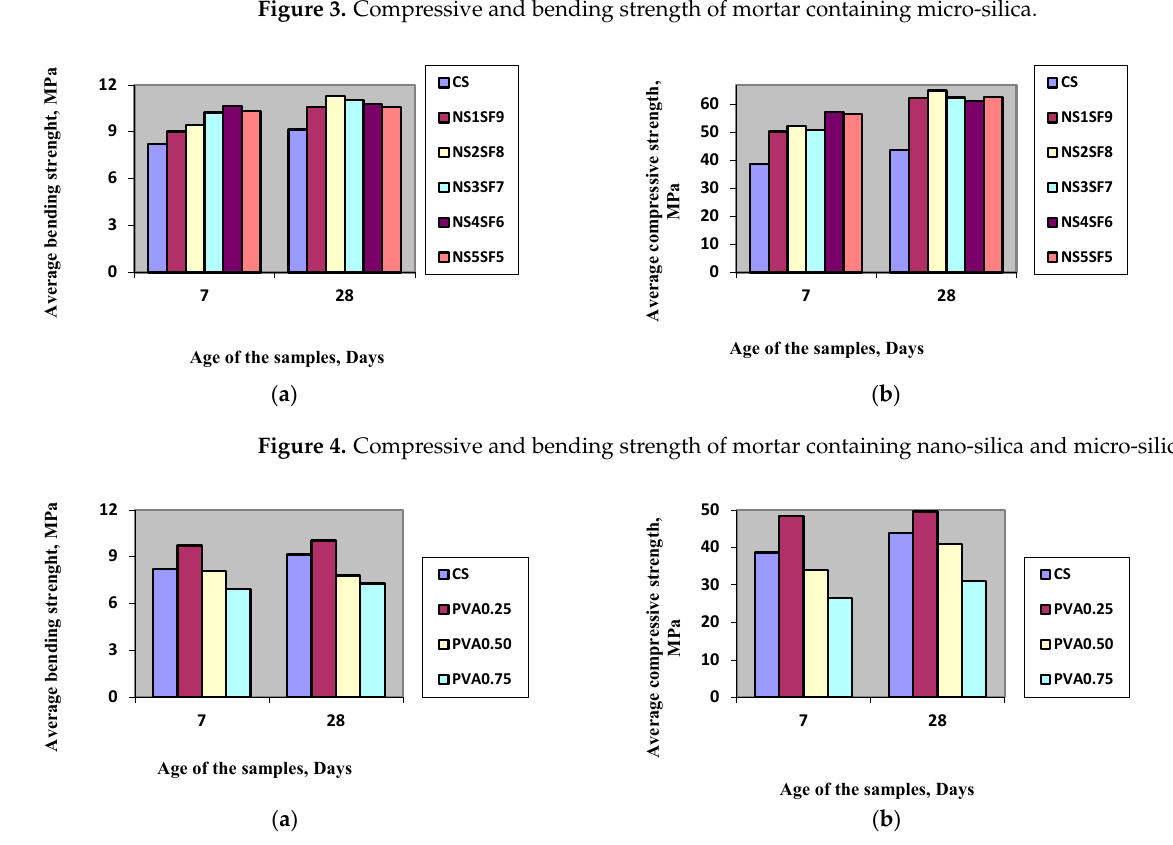
Figure 5. Compressive and bending strengths of mortar containing PVA fiber.